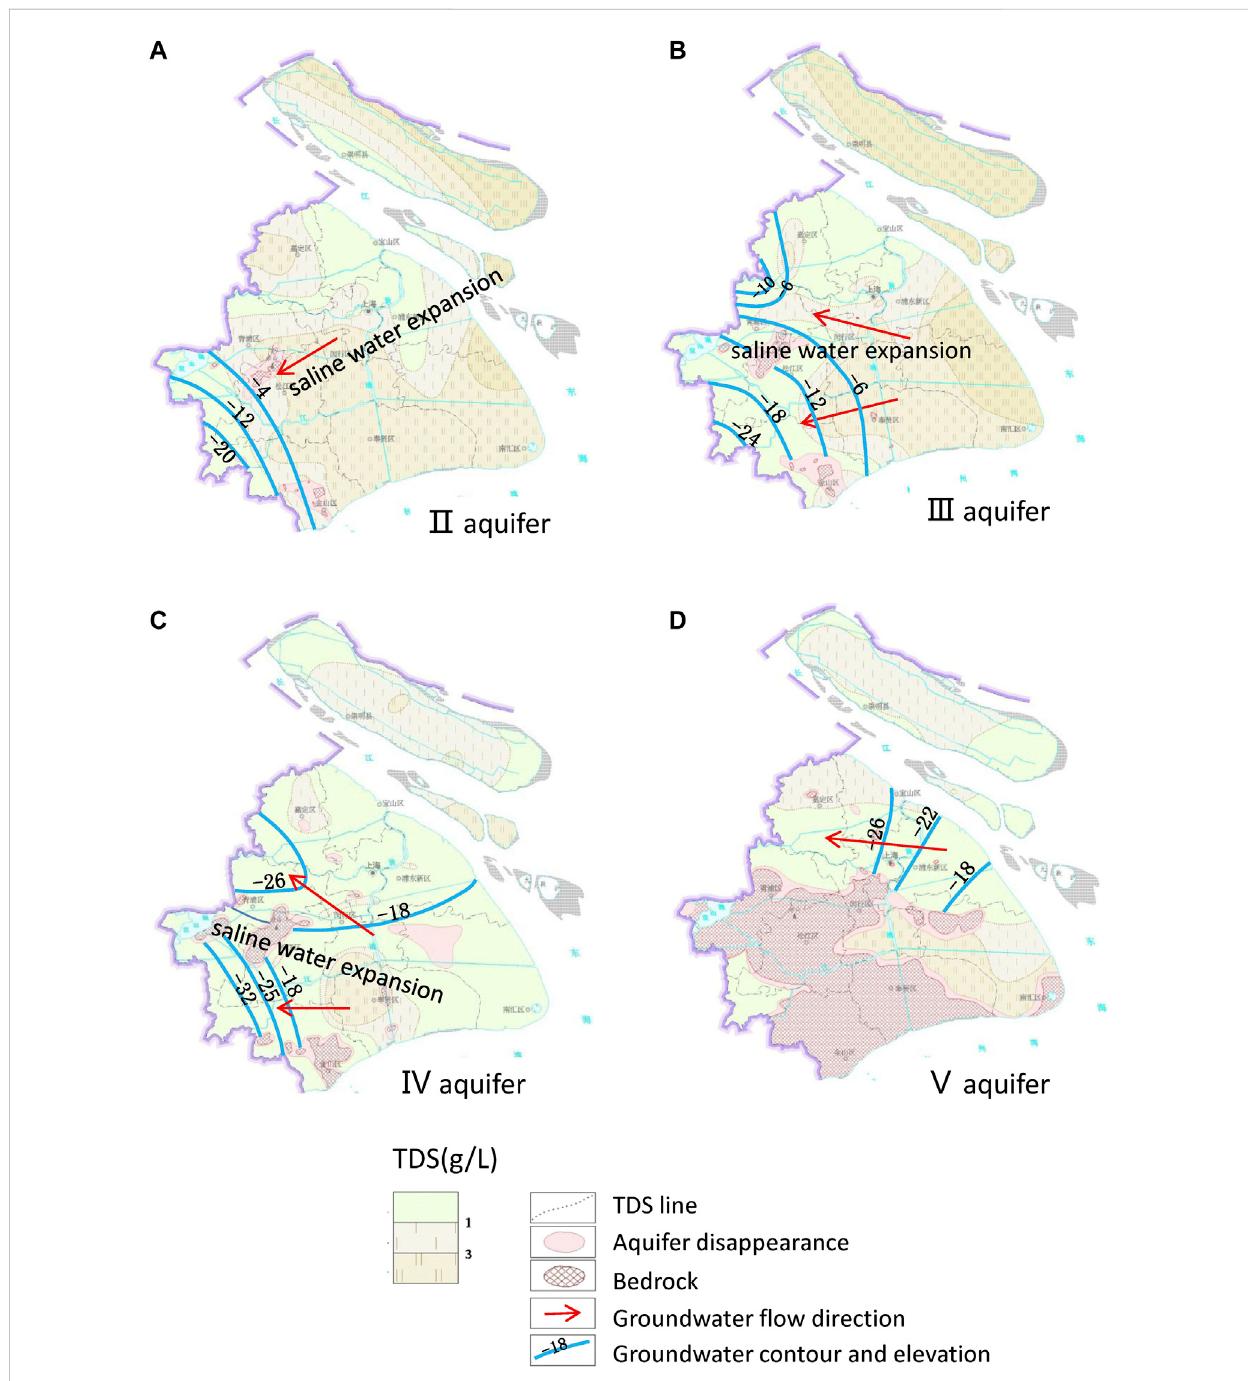
FIGURE 9 TDSandgroundwaterlevelsinthestudyareain2009.TDSdataarederivedfromWeietal.(2010).Groundwaterlevelsand fl owdirectionsarederived from Gong, (2009). (A) Groundwater funnels in aquifer II were mainly located in Songjiang in the southwest of the study area. (B) Groundwater funnels in aquifer III were mainly located in Songjiang and Qinpu in the western part of the study area. (C) Groundwater funnels in aquifer IV are similar to those in aquiferIII.SalinerechargefromaquiferIIItoaquiferIVintheareaconnectingtheaquifershasbeenexacerbatedbyadeclineingroundwaterlevelsin aquifer IV. (D) Groundwater generally fl owed from east to west due to the decline in groundwater levels in the west part of aquifer